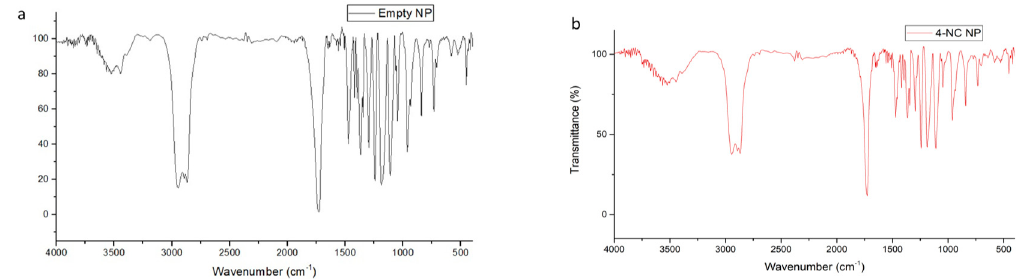
Figure 9. FT-IR spectra for NP. ( a ) Empty, ( b ) with 4-NC loaded.